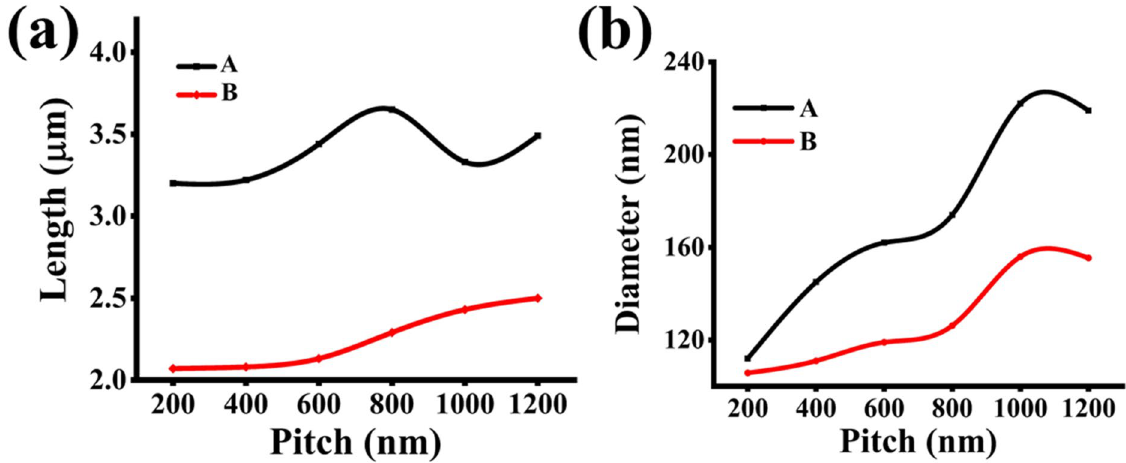
Figure 3. ( a ) Length versus pitch for high vertical yield samples. ( b ) Diameter versus pitch for high vertical yield samples.